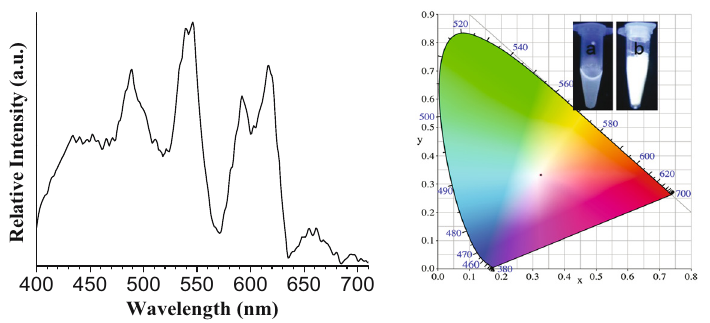
Figure 5: Emission spectra of LMOCP4 with the excitation wavelength of 273 nm ( 4 ) ( left ) and its corresponding CIE chromaticity diagram ( right ) . Inset is the photograph of the solution and a solid powder sample of LMOCP 4 under the